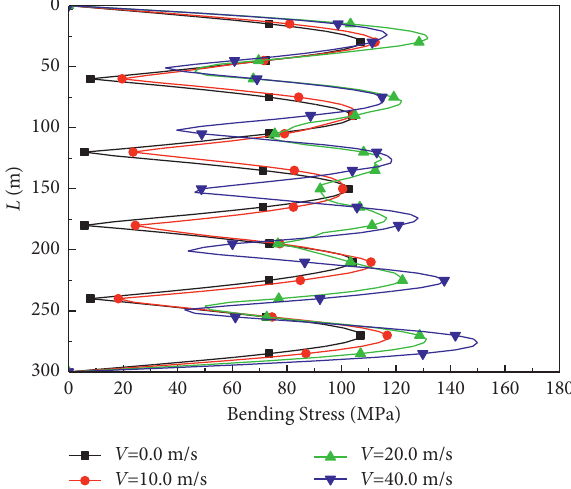
Figure 9: VIV bending stress distribution of riser under different internal flow